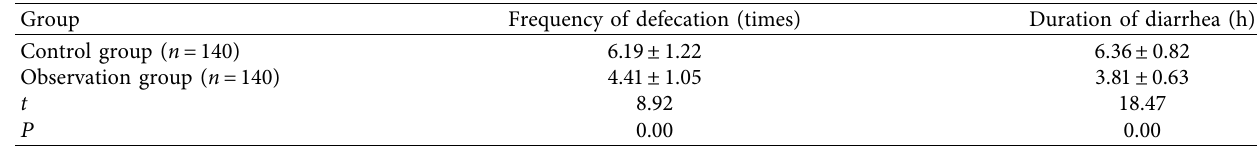
Table 2: Comparison of bowel preparation time between two groups ( x ± s ).